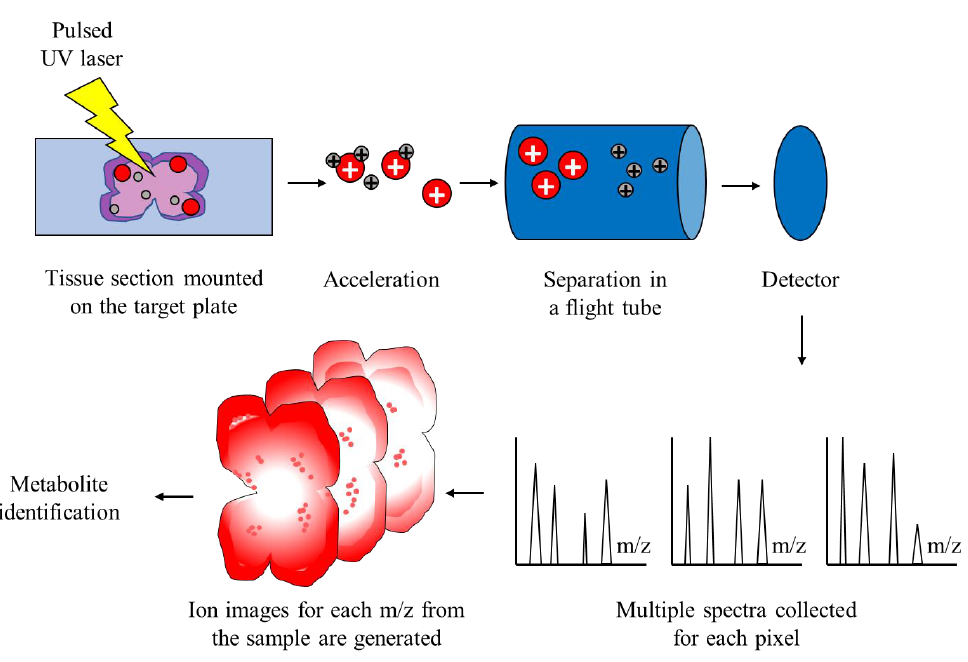
Figure 1. Schematic representation of MALDI-TOF IMS. The sample is embedded in a matrix solution and applied onto the target plate. Spots on the target plate are pulsed with an ultraviolet laser, which induces ablation and desorption of the molecules, which are now ionized and accelerated in an electrical field. Ionized molecules are separated in a flight tube without an electric field based on their m/z . The time of flight, which is correlated with the mass of particles, is captured by a detector and the final spectrum is generated for each pixel of the sample. Finally, metabolites are identified according to the generated spectra.